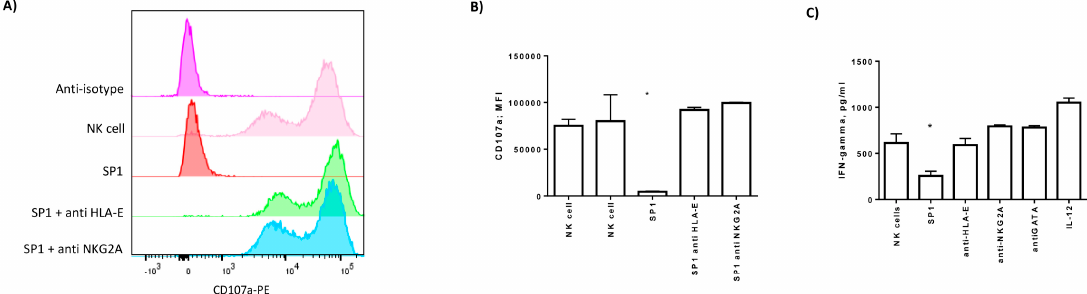
Figure 7. ( A ) Representative histograms of NK cell degranulation towards Beas-2B cells transfected with SP1 protein without or with anti-HLA-E, anti-NKG2A, or anti-isotype control. NK cells were marked with CD56 and gated as reported in Figure S1C. The degranulation was assessed by CD107a-PE expression. ( B ) MFI of CD107a in NK cells after the co-culture with Beas-2B cells transfected with SP1 protein without or with anti-HLA-E, anti-NKG2A, or anti-isotype control. The values are presented as mean ± standard deviation. * significant p values Student t test. ( C ) Secretion of IFN-gamma evaluated by ELISA. IL-12 treatment was used as a control of IFN-gamma